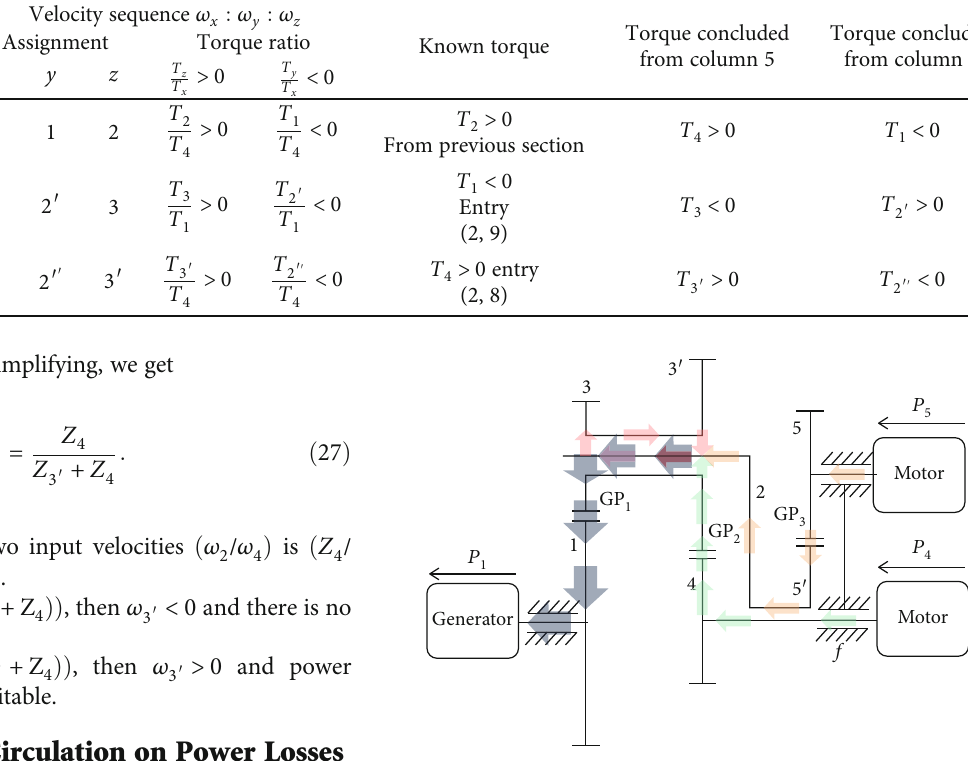
Figure 10: Power fl ow through di ff erent elements of the